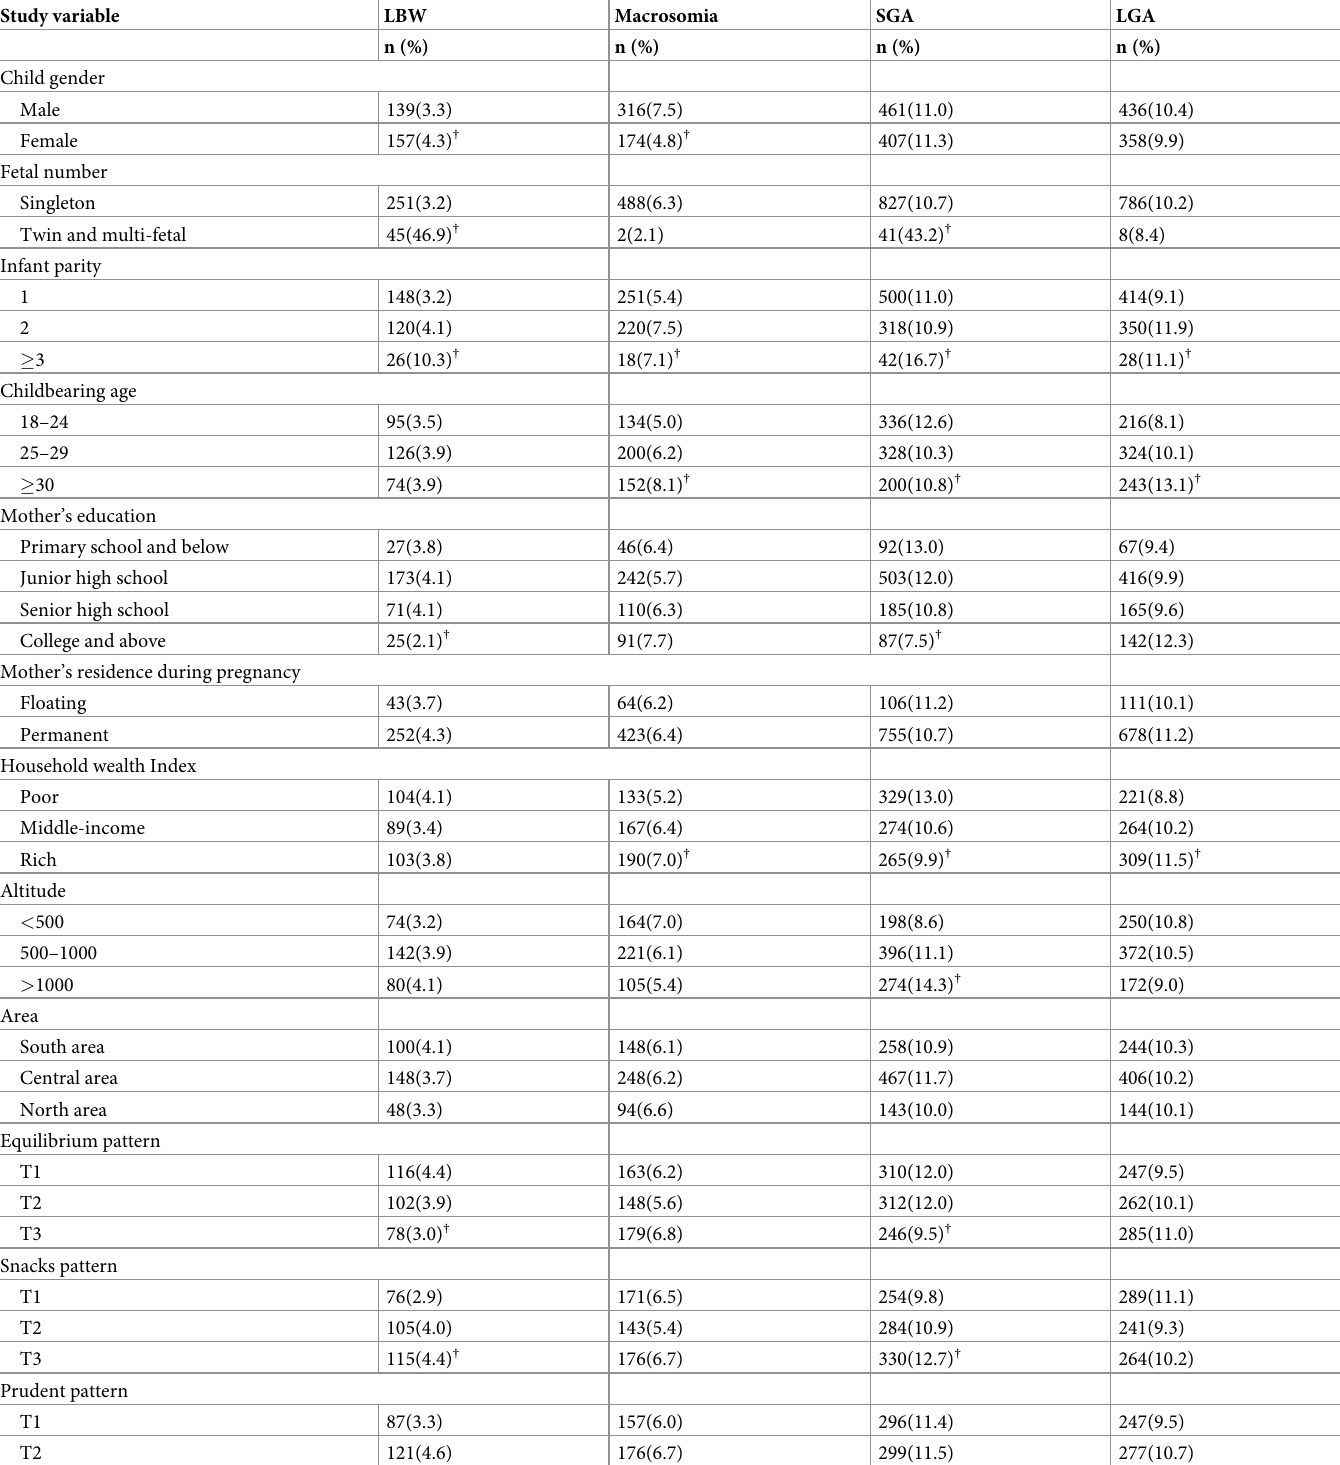
Table 3. Baseline characteristics of study population (n 7934) in Shaanxi province, Northwest China, 2013 �